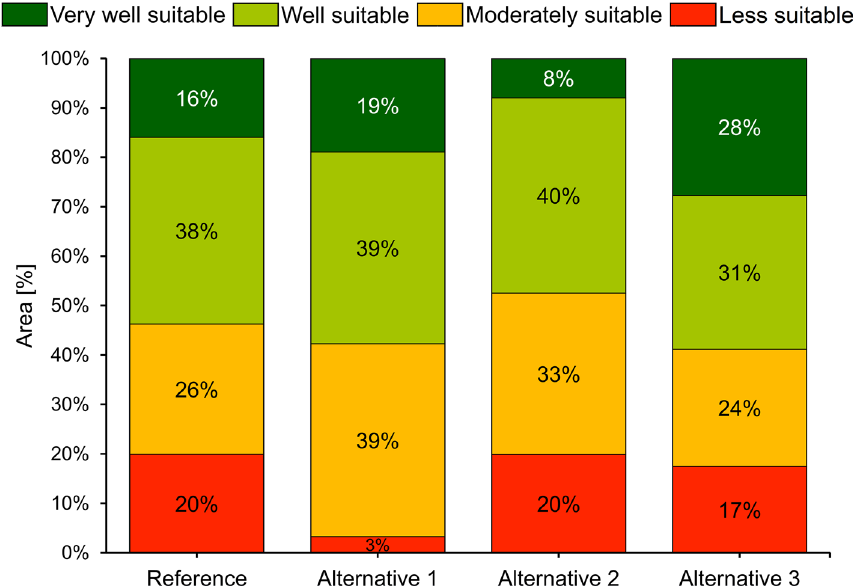
Fig. 7 Percentage shares of ATES suitability potential classes in Germany for the reference as well as the three alternative weighting schemes with regard to the time period near future (2021–2050). The shares refer to the parts of Germany that are not covered by hard rock or inland water surfaces (Additional file 1: Fig.